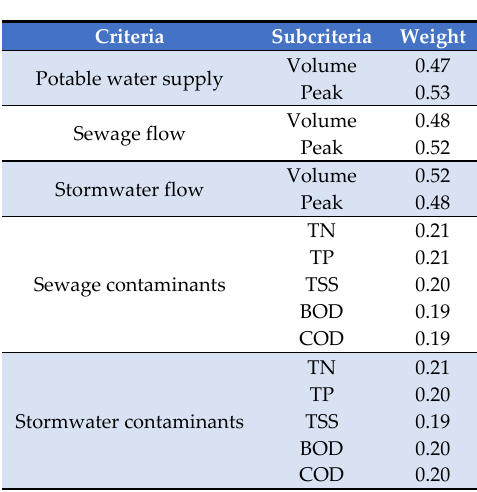
Table 2. Weight for subcriteria [46].